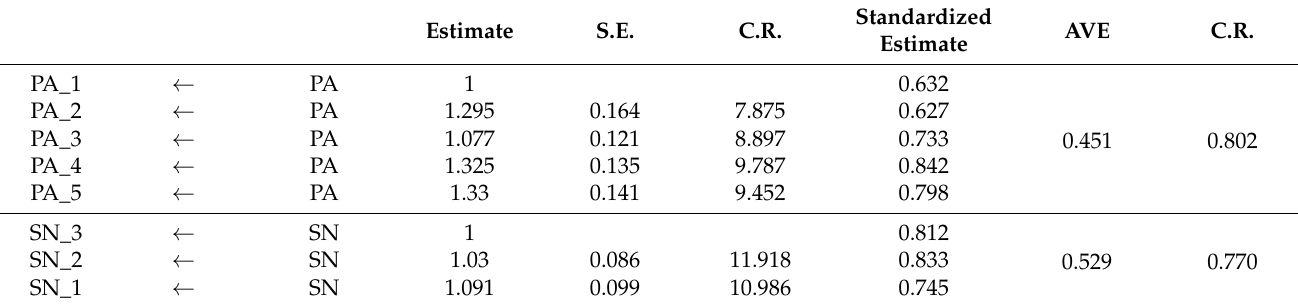
Table 3. Convergent